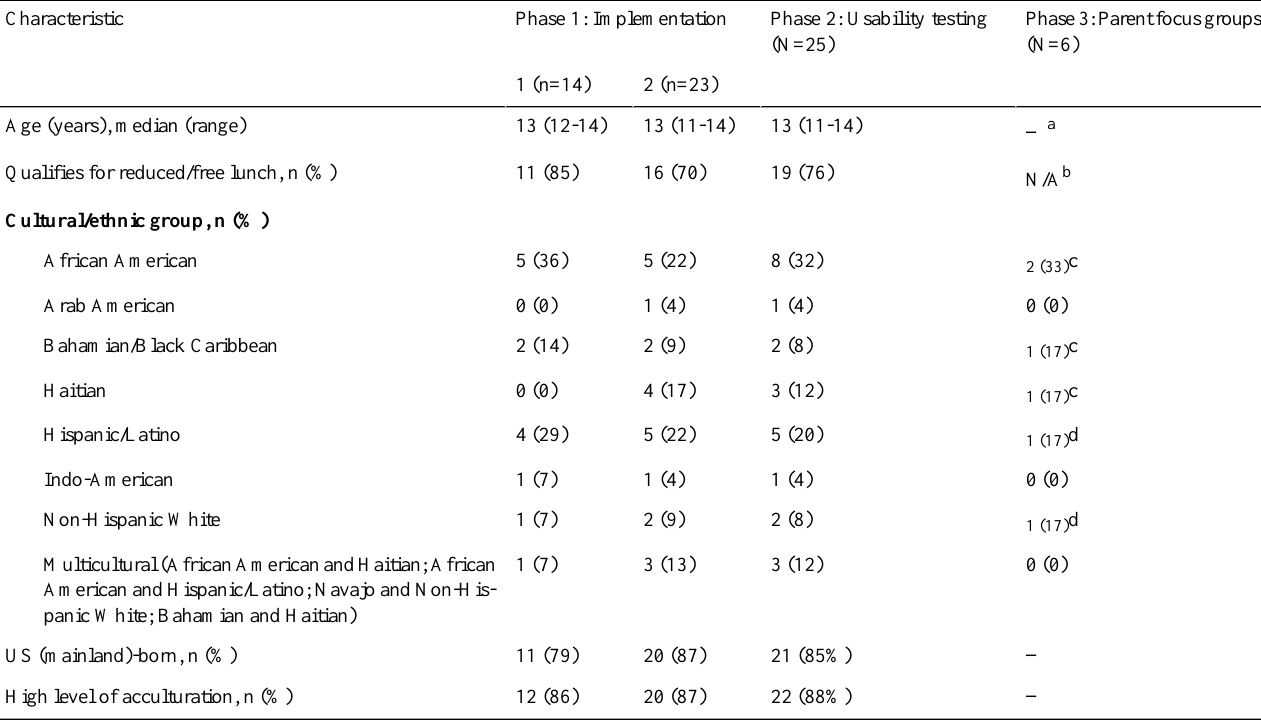
Table 1. Demographic characteristics of participants by study